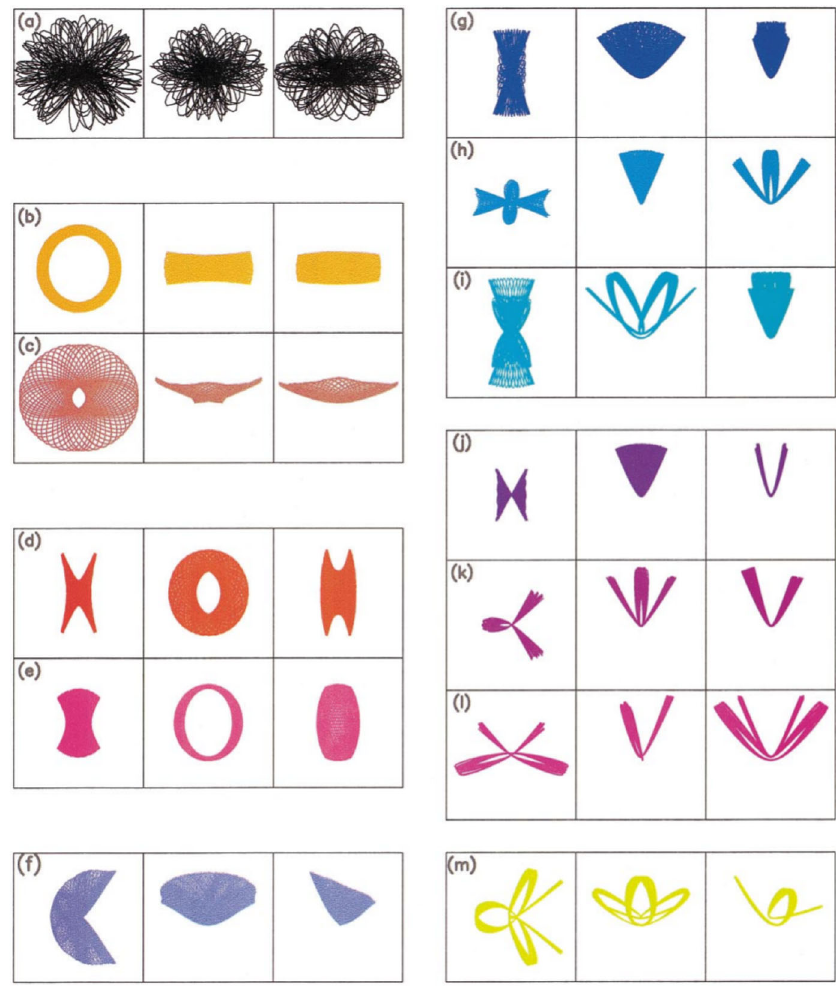
Fig. 12 From the left to the right and from the top to the bottom, we have stochastic orbits, short-axis tube orbit, saucer orbit, a resonant short-axis tube, inner long-axis tube, long-axis tube, resonant, pyramid, resonant pyramid, resonant pyramid orbit, banana orbit, 2 : 3 : 4 resonant banana, 3 : 4 : 6 resonant banana, and a 6 : 7 : 8 resonant orbit.We note that the projectionsof “tube”, centrophilic stellar orbits arounda MBH in triaxial nuclei will look aligned in one or another plane depending on the potential. Image reproduced with permission from Poon and Merritt (2001), copyright by